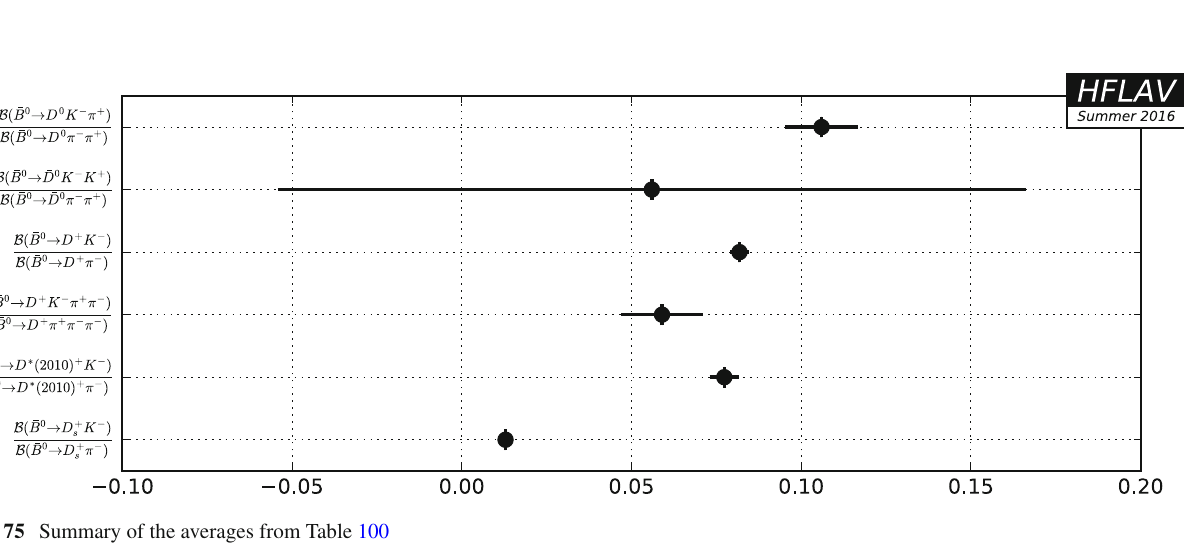
Fig. 75 Summary of the averages from Table 100